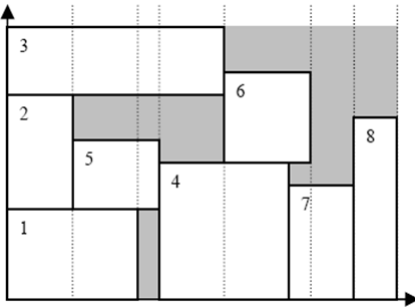
Figure 1. Example of SubFF executing for the sequence: {1,2,3,4,5,6,7,8}.